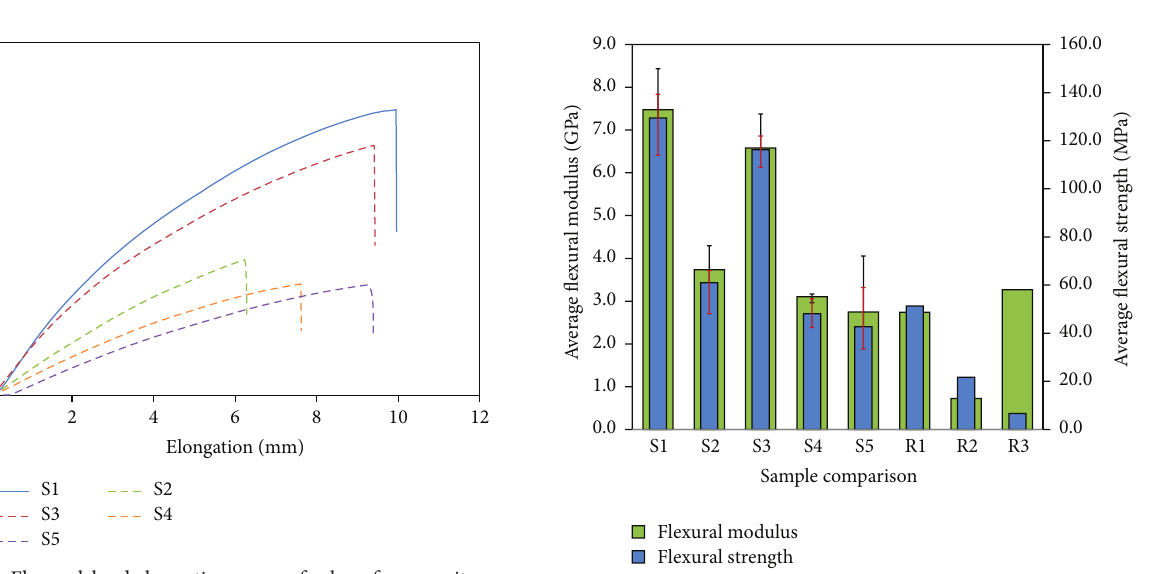
Figure 10: Flexural modulus and flexural strength of kenaf compos- ites.